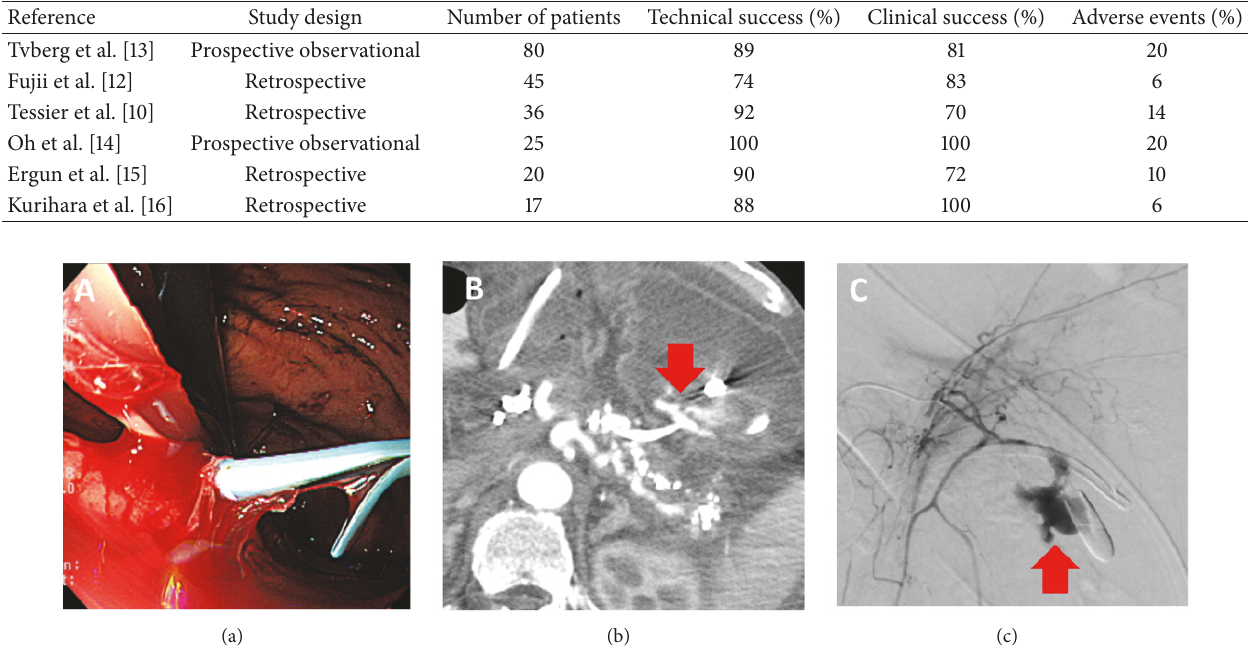
Figure 2: Bleeding occurred at the 371st day after EUS-PD in case 3. (a) Arterial bleeding from the transgastric puncture tract. (b) Contrast- enhanced computed tomography revealed extravasation into the stomach (arrow). (c) Interventional radiology revealed a pseudoaneurysm from the left gastric artery (arrow), and arterial embolization was